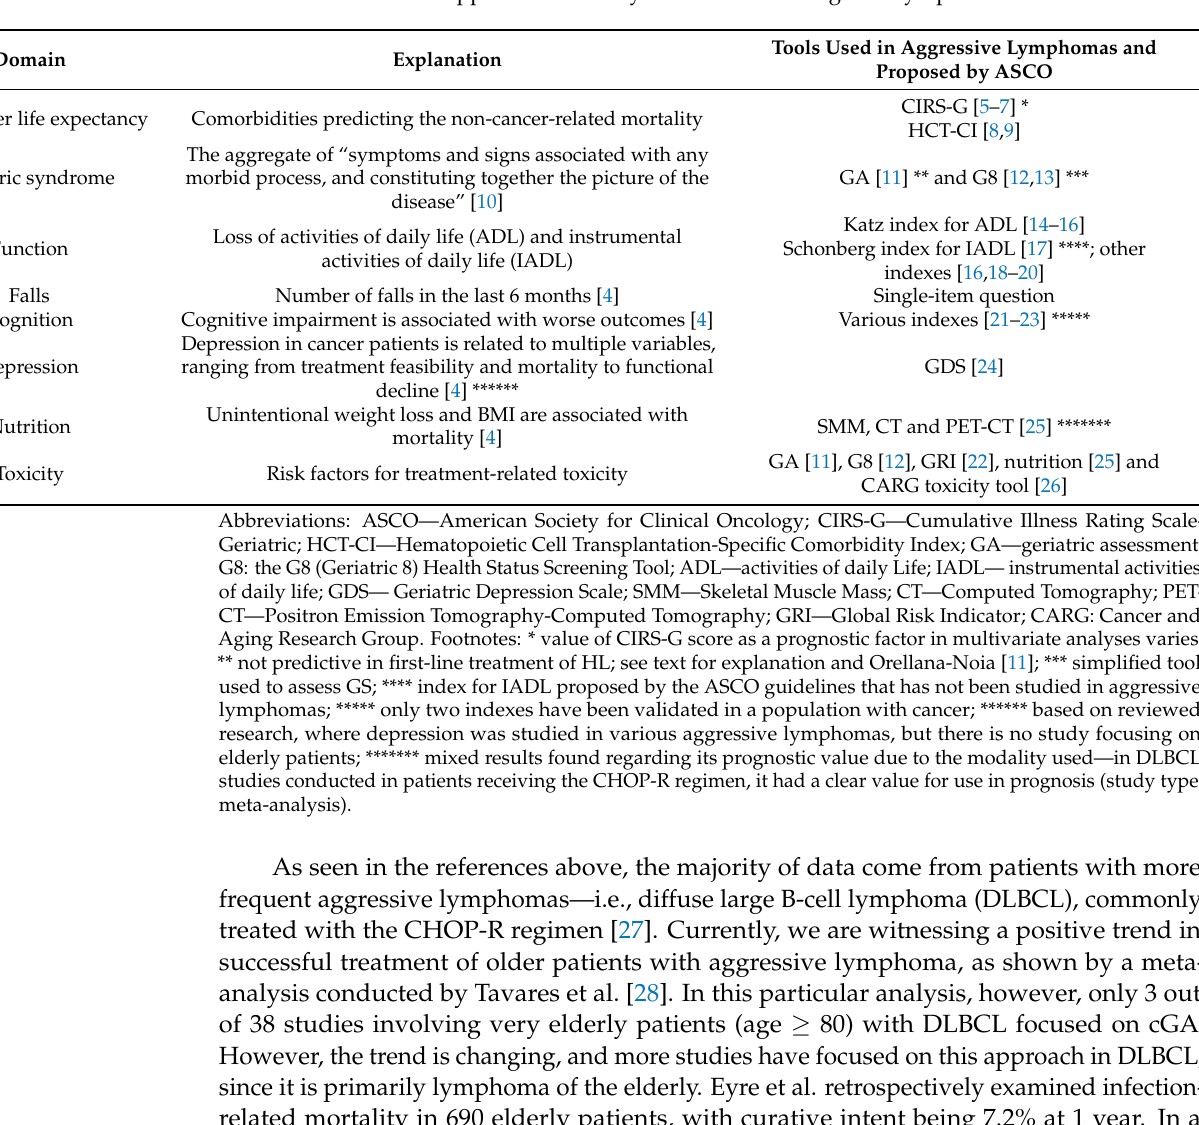
Table 1. The Geriatric Approach to Elderly Patients with Malignant